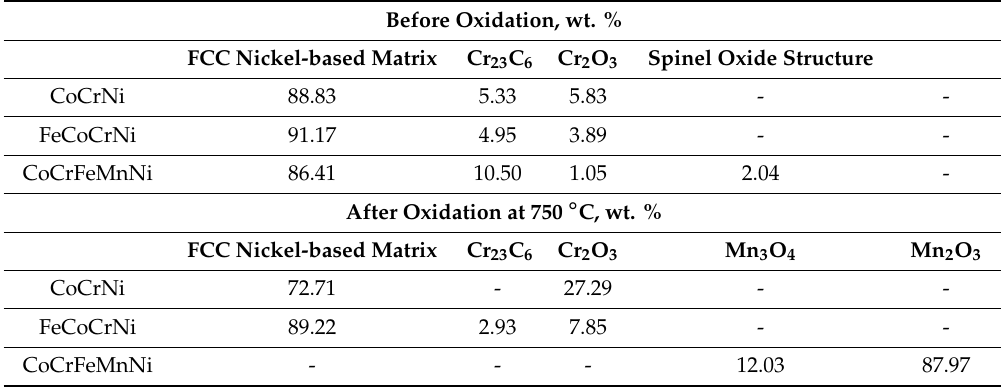
Figure 1. Phase composition of the prepared alloys showing a single-phase FCC matrix lattice for all alloys; the CoCrNi and FeCoCrNi contain additional Cr 23 C 6 and Cr 2 O 3 phases, and the CoCrFeMnNi also contains a spinel phase. The peak positions are designated by numbers referring to the legend in the top right corner. Table 2. Phase content of the alloys measured by XRD after sintering and in the oxide scales developed after air exposure at 750 ◦ C and 950 ◦ C. The analysis of CoCrFeMnNi after 750 ◦ C oxidation includes only the top oxide layer due to the large scale thickness; no analysis is provided after 950 ◦ C oxidation due to the massive spallation of the oxide scale.